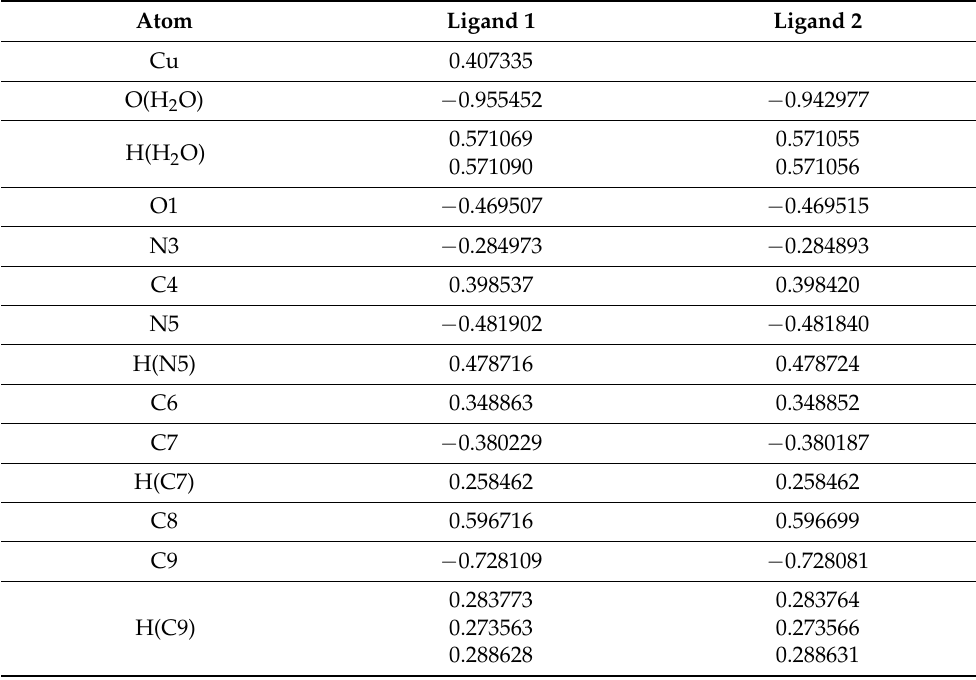
Figure 13. MEP surface of ( 1 ). Table 8. Mulliken charge distribution of all atoms in ( 1